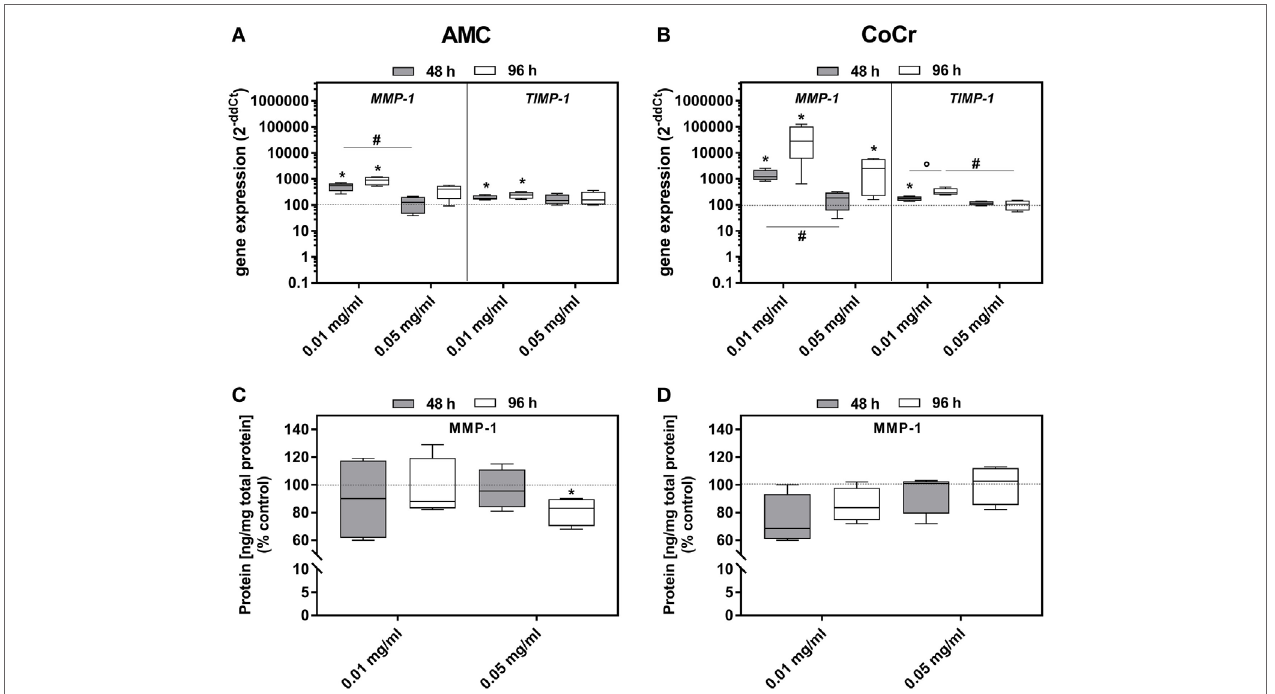
FigUre 6 | MMP-1 and TIMP-1 expression rates in human osteoblasts following exposure to AMC and CoCr particles. Gene expression levels of MMP-1 and TIMP-1 by qRT-PCR (a,B) were determined in cells treated with the respective particle type. (c,D) Cell culture supernatants were used to evaluate the concentration of activated MMP-1 protein (per total protein content). Data are shown as median and minimum/maximum values ( n = 4). Significances between groups were calculated with the Mann–Whitney U -test (* p < 0.05, treated vs. untreated; # p < 0.05, 0.01 vs. 0.05